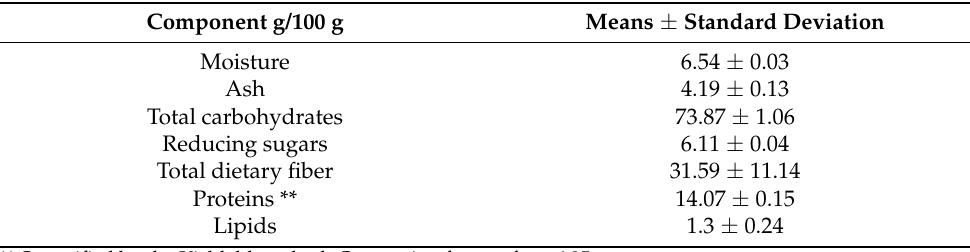
Table 2. Proximate composition of jackfruit seed flour in dry basis.